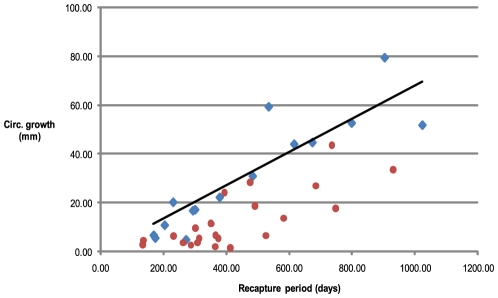
Circumferential growth rates of Nautilus pompilius at Osprey Reef.
Nautilus which were immature at both first capture and recapture (diamond symbol, n = 15) were used to calculate growth rate. A linear regression showed a growth rate of 0.068 mm/day while mean growth rate = 0.0614±0.023 mm day−1). Individuals which were immature at first capture but matured during the time before recapture (circle symbol, n = 23) showed varied growth rates, all <0.0614 mm day−1.